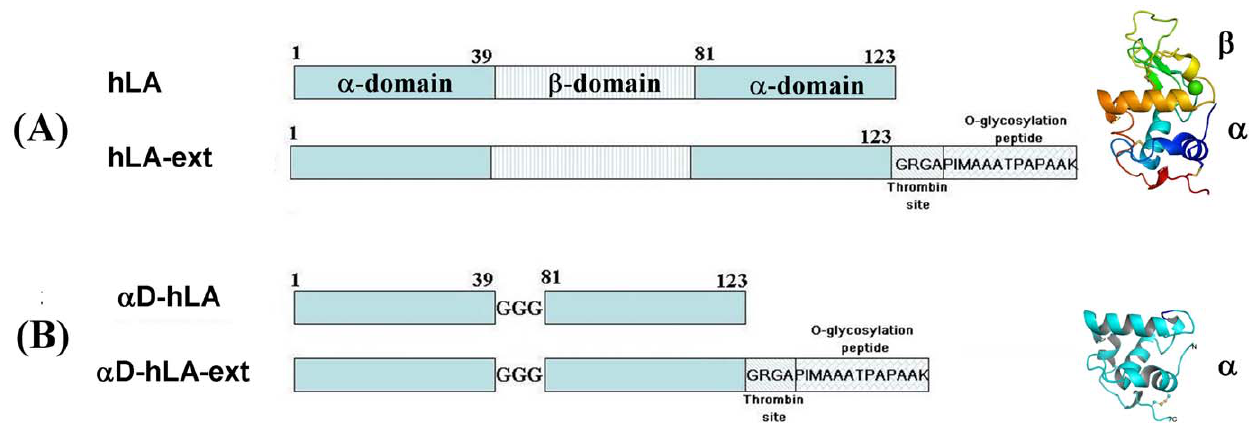
Figure 1. Schematic diagram of the hLA and a D-hLA proteins with C-terminal extension. (A) hLA (protein sequence acc. No J00270) and hLA-ext proteins with the crystal structure of hLA (far right) (pdb 1a4v) showing alpha and beta domains. (B) a D-hLA and a D-hLA-ext proteins with the corresponding alpha domain structure (model) (far right). Since the alpha domain is comprised of N-terminal residues, 1 to 39, and the C-terminal residues, 81 to 124, of hLA (cyan colored), a three residue glycine linker was used to fuse the N-terminal and C-terminal fragments to construct the alpha domain form of the protein ( a D-hLA) where beta domain is removed. A 17-amino-acid extension containing a thrombin cleavage site and a Thr residue (substrate for ppGalNAcT2 enzyme), was engineered at the C-terminal domain of hLA (A, hLA-ext) and a D-hLA (B, a